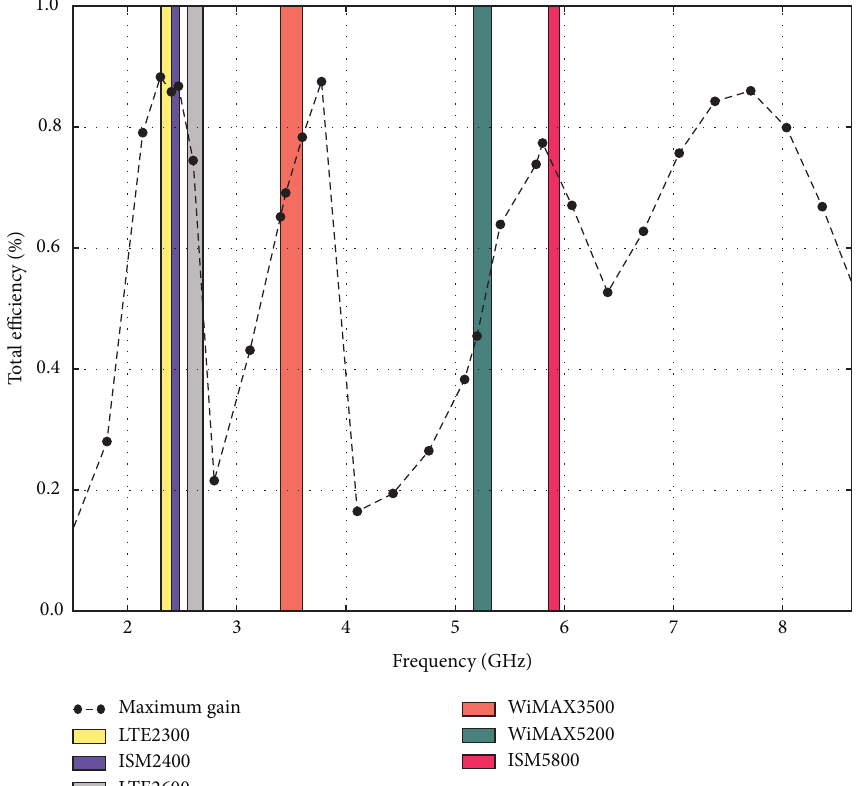
Figure 12: Variation of the total efficiency over frequencies.